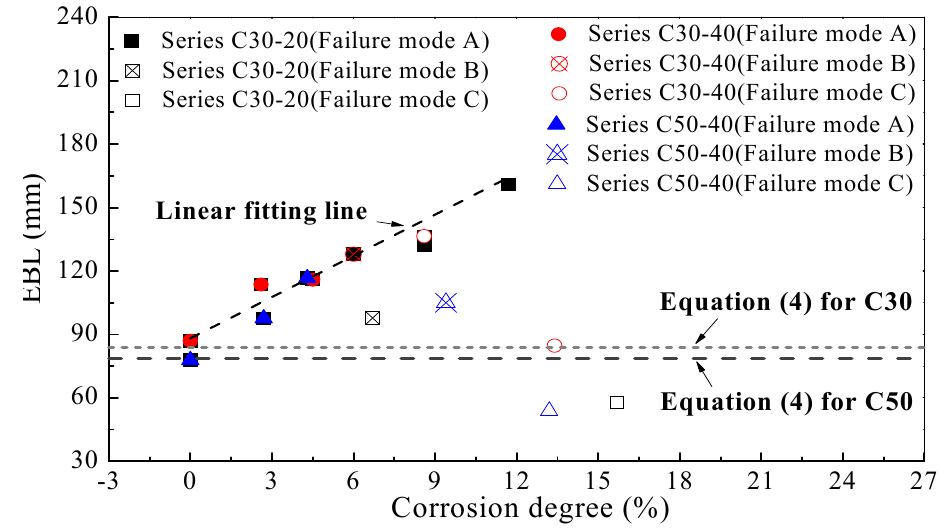
Figure 7. EBL—corrosion degree relationship .